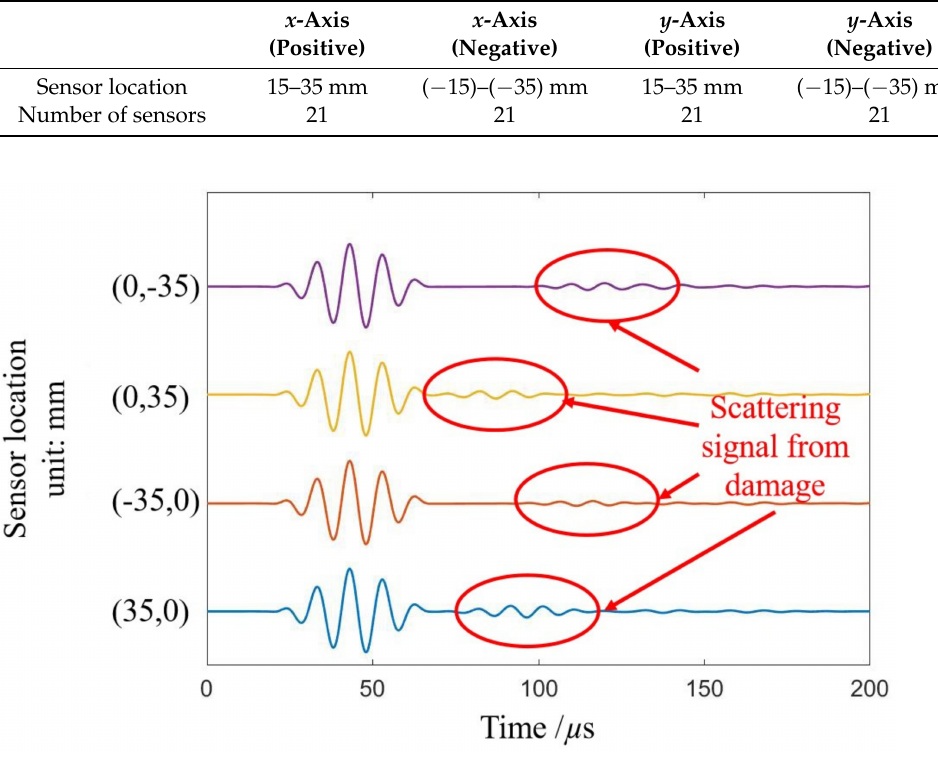
Figure 4. Wave-field diagram of the orthotropic composite. Table 2. Location and number of sensors of the four sensor arrays.